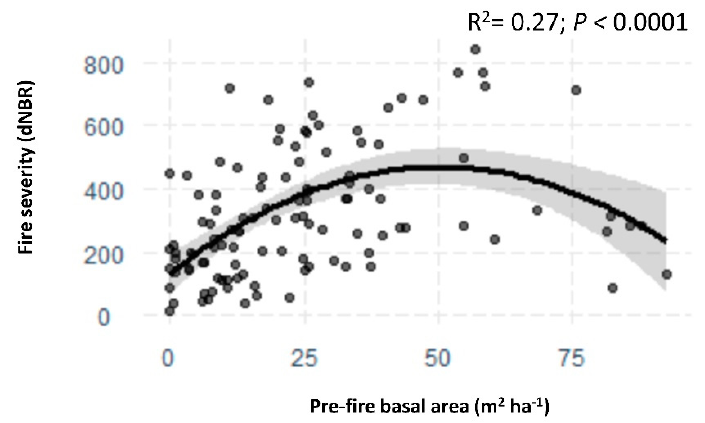
Figure 4. Polynomial regression model results of pre-fire basal area on Horseshoe Two Fire severity (dNBR) influences on stand structural changes in tree basal area from 2002/3 to 2017/18 plotted with 95% confidence intervals in gray. Pre-fire tree basal area was significant positive influence on fire severity in Chiricahua National Monument.